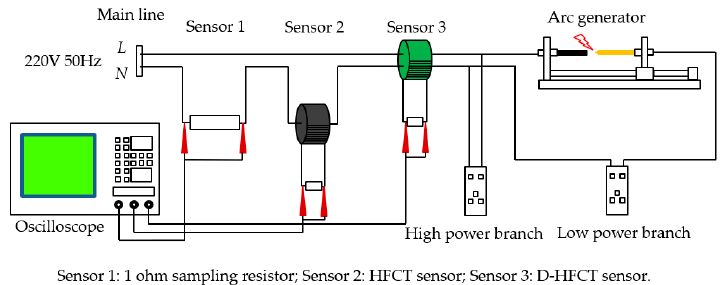
Figure 24. Schematic diagram of the high-power shielding load experiment.